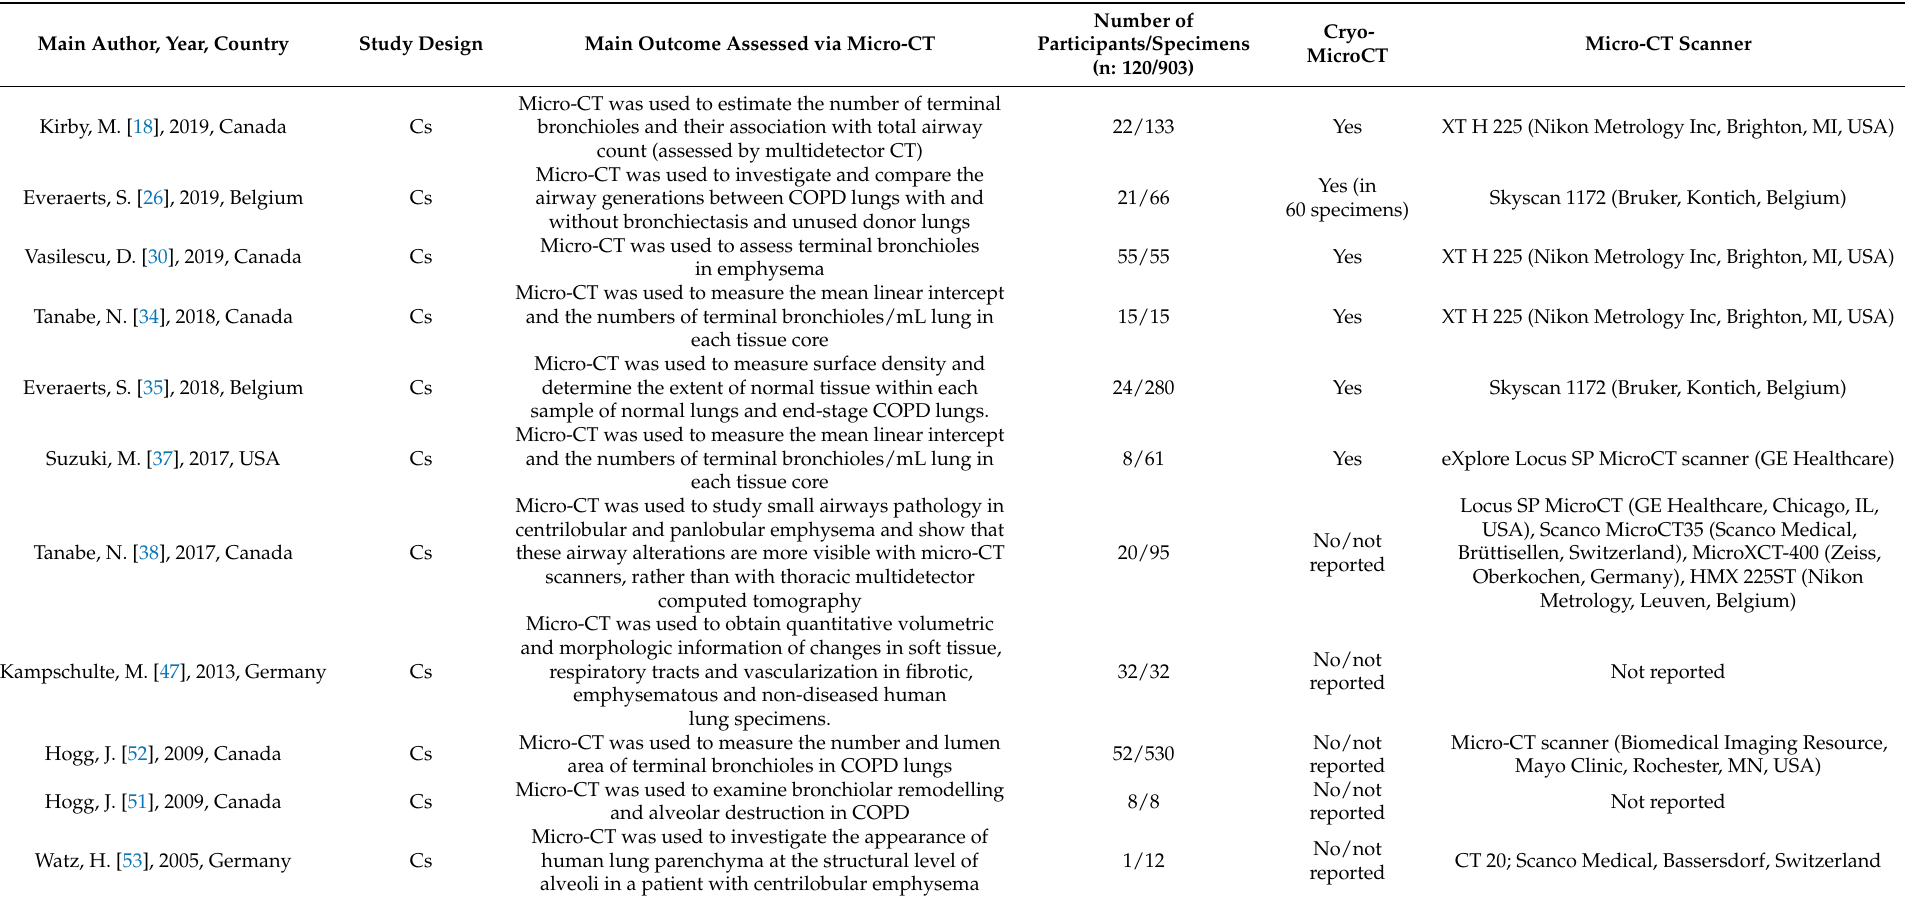
Table 3. Studies using micro-CT for measurement and evaluation of pathological changes in chronic obstructive pulmonary disease